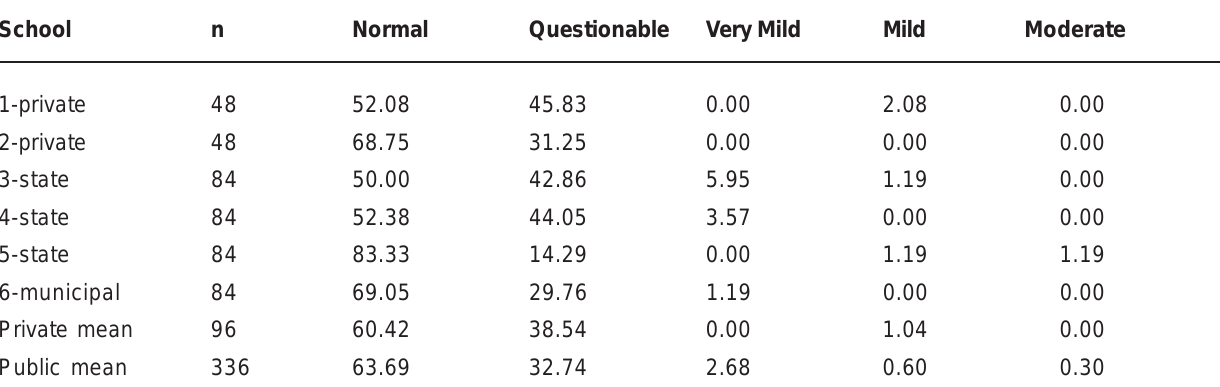
TABLE 3- Dental fluorosis prevalence (%) according to age and gender, in Catalão, 2001